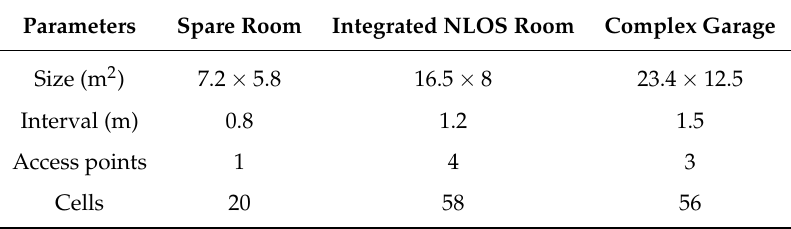
Table 1. Main parameters of the